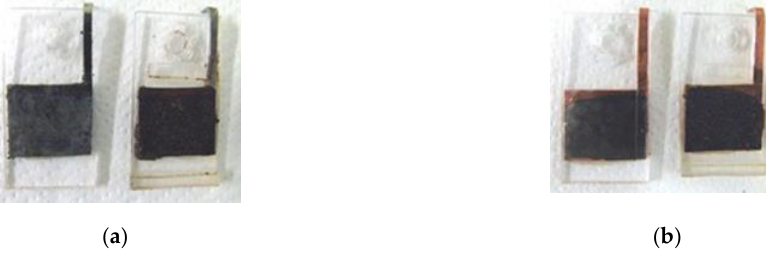
Figure A2. Images of vulcanized MCF rubber on anode by electrolytic polymerization: ( a ) stainless electrodes; ( b ) copper electrodes; right is the cathode and the left is the anode. Sensors 2019 , 19 , x FOR PEER REVIEW